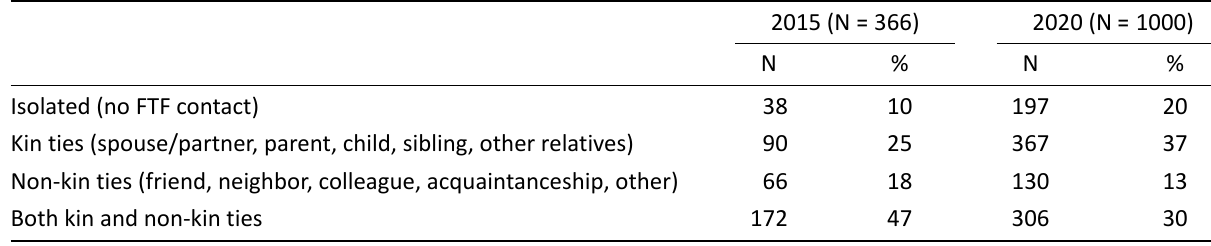
Table 3. Ego’s face‐to‐face contact network